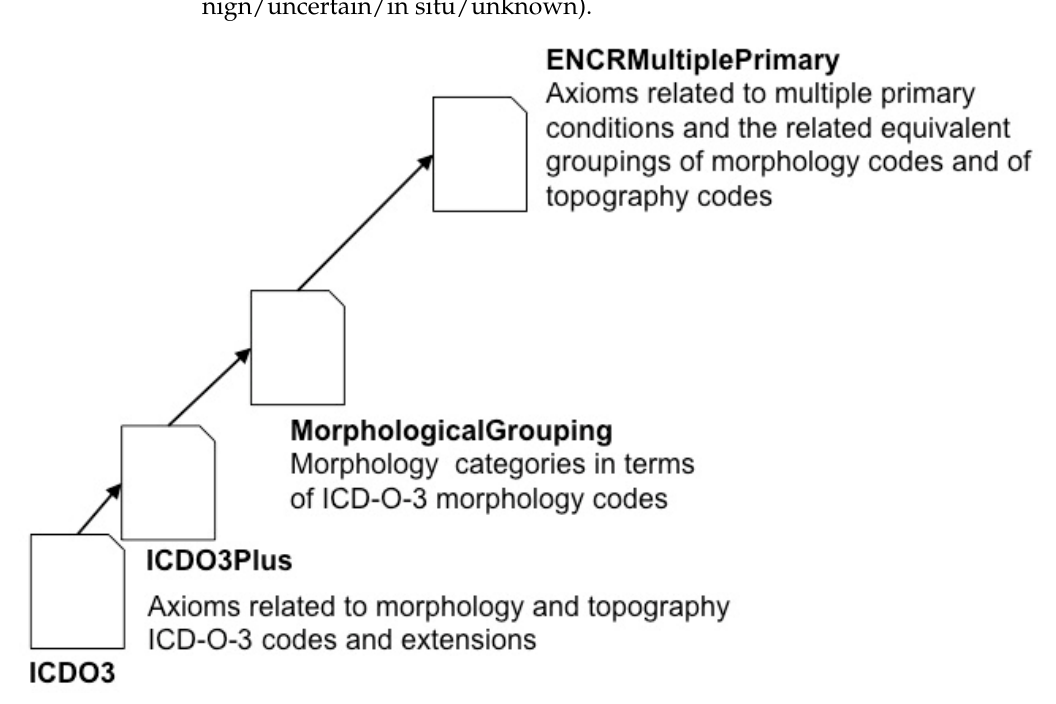
Figure 2. Ontology tree comprising the MPT-validation check. Within the ICD-O-3 sub-ontologies, topography, morphology, and behaviour are repre- sented by their own OWL classes. Three-digit topographies (e.g., C028) are subclassed from their two-digit counterparts (e.g., C02). Two-digit topographies may be used in the axiom rule-bases but individuals are only created from the three-digit topographies.